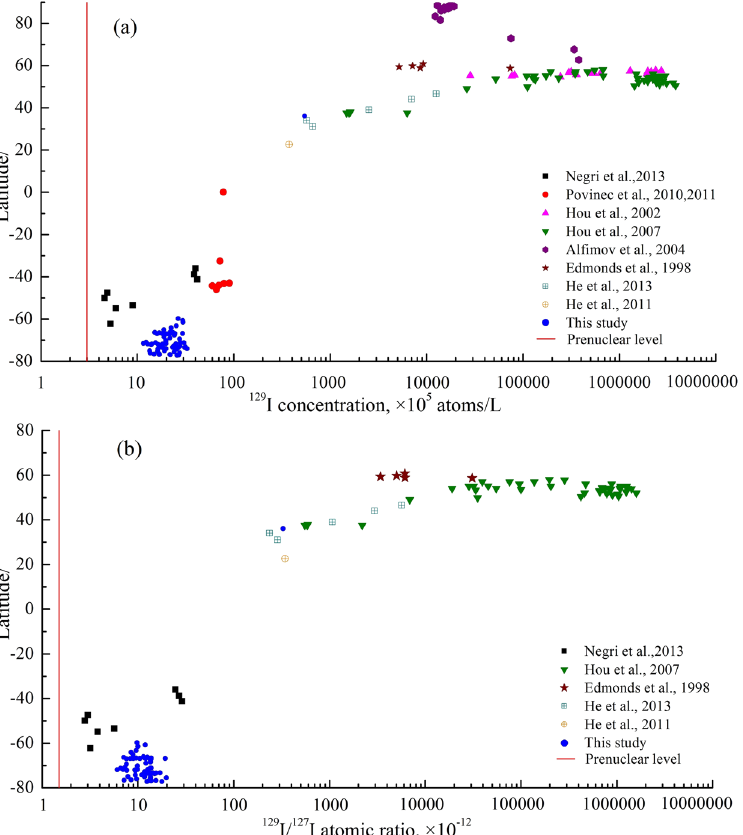
Figure 3. Comparison of 129 I concentrations ( a ) and 129 I/ 127 I atomic ratios ( b ) in Antarctic seawater with those in other marine waters. The red line indicates pre-anthropogenic values. The data of five locations (7, 37, 42, 45 and 51) have been reported in the Ref.